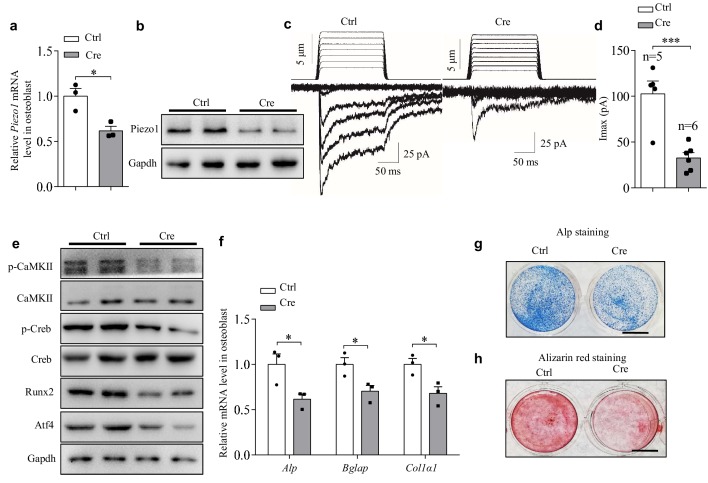
Characterizations of primary osteoblasts derived from Piezo1fl/fl mice with or without ectopic expression of the Cre recombinase.(a, b) QRT-PCR analysis of Piezo1 mRNA level (a) and western blot analysis of Piezo1 protein level (b) in osteoblasts derived from Piezo1fl/fl mice after transfection with pIRES-EGFP (Ctrl) or pCAG-Cre-IRES2-GFP (Cre) plasmid. (c) Representative traces of poking-induced inward currents recorded at −60 mV in an osteoblast from Piezo1fl/fl mice after transfection with Ctrl or Cre plasmid. Cells with green fluorescence were used to record current. (d) Scatter plots of the maximal poking-induced currents in osteoblasts from Piezo1fl/fl mice after transfection with Ctrl or Cre plasmid. (e) Western blot analysis of p-CaMKII, CaMKII, p-Creb, Creb, Runx2 and Atf4 proteins in osteoblasts from Piezo1fl/fl mice after transfection with Ctrl or Cre. (f) QRT-PCR analysis of Alp, Bglap and Col1α1 mRNA levels in osteoblasts from Piezo1fl/fl mice after transfection with Ctrl or Cre plasmid. (g) Representative images of Alp staining in osteoblasts from Piezo1fl/fl mice after transfection with Ctrl or Cre plasmid in osteogenic medium for 5 days. Scale bar, 5 mm. (h) Staining of calcium deposition by Alizarin red in osteoblasts derived from Piezo1fl/fl mice after transfection with Ctrl or Cre plasmid in osteogenic medium for 14 days. Scale bar, 5 mm. All data are the mean ± s.e.m. from three independent experiments. *, p<0.05; ***, p<0.001.